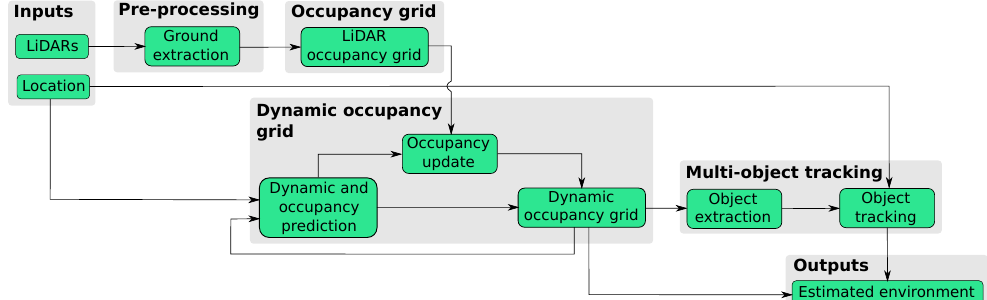
Figure 1. Perception framework